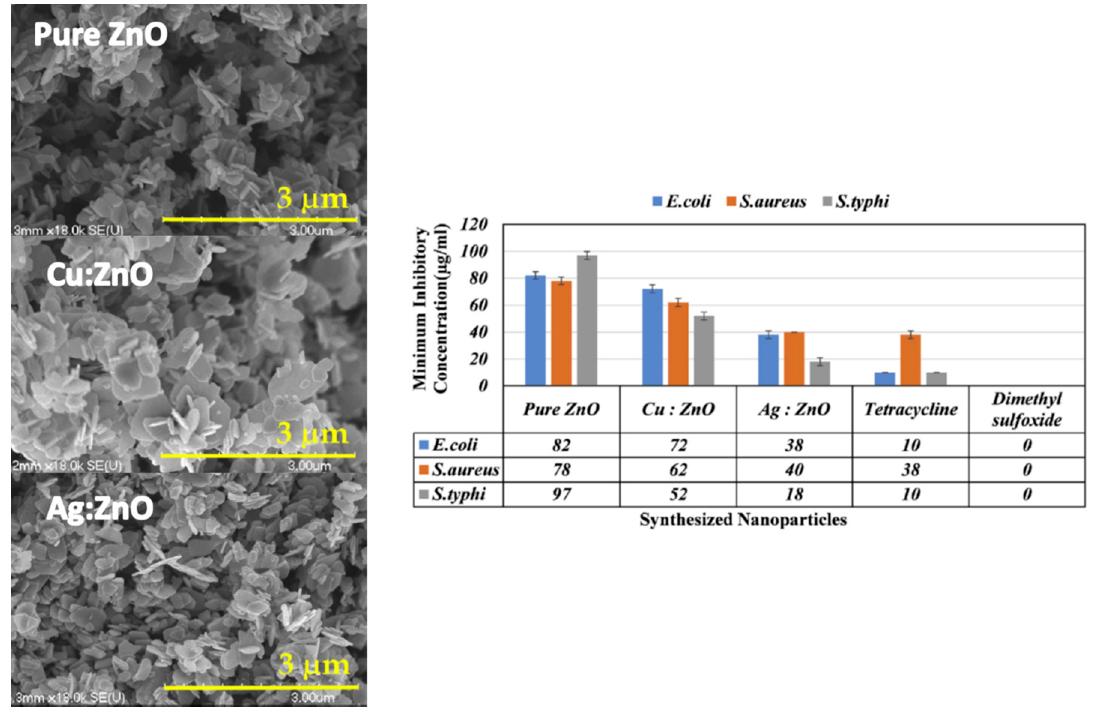
Figure 5. SEM images and antimicrobial performances of Cu- and Ag-doped nanoplates. Adapted from ref. [152] . from ref.